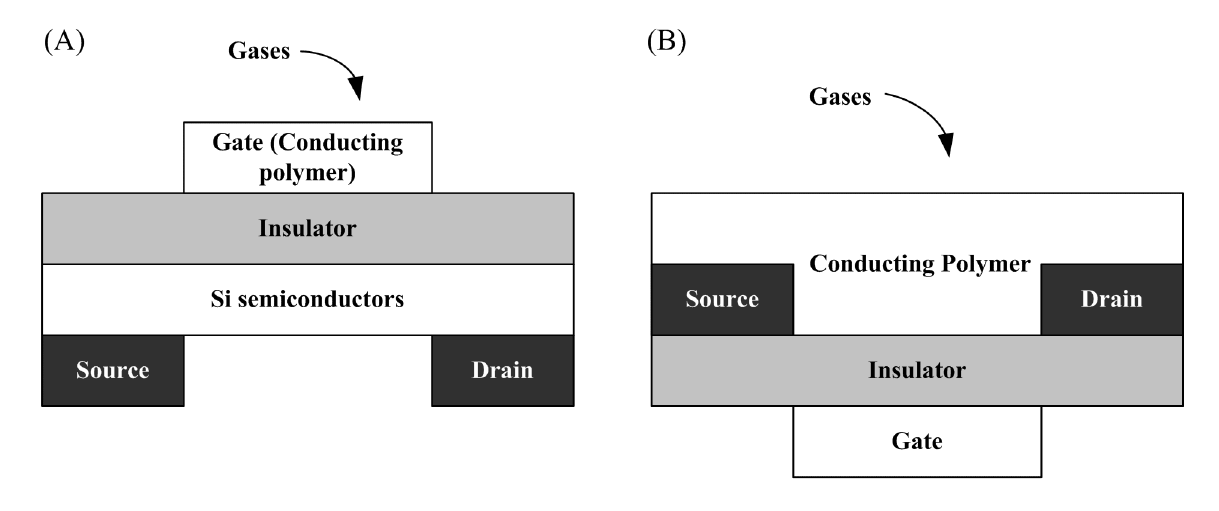
Figure 6. Configuration of TFT (A) and IGFET